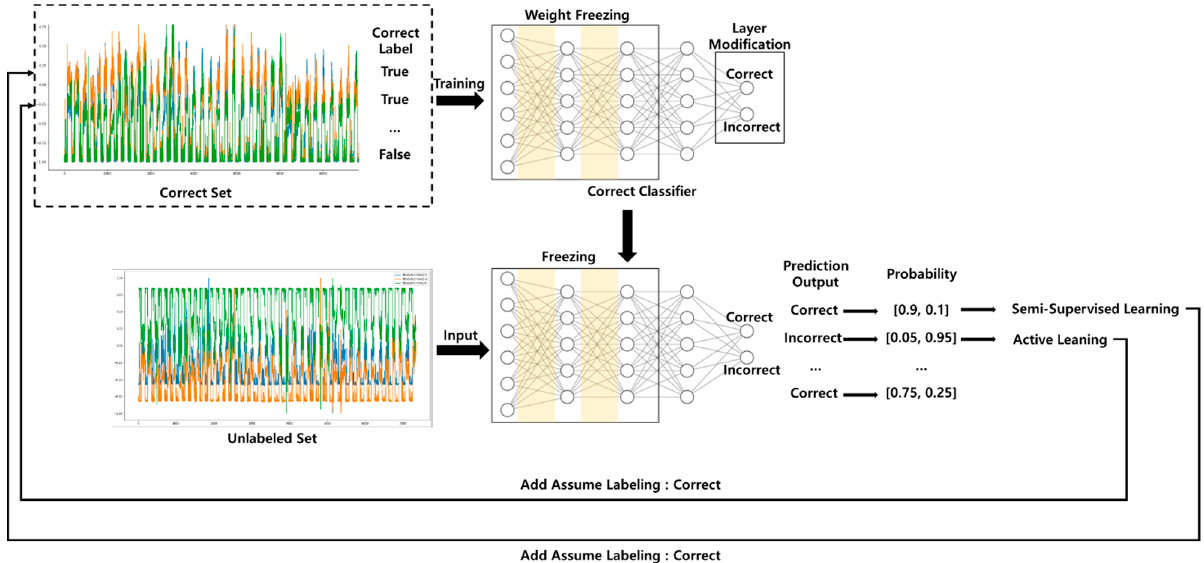
Figure 5. Correct classifier training of semi-supervised active transfer learning architecture.